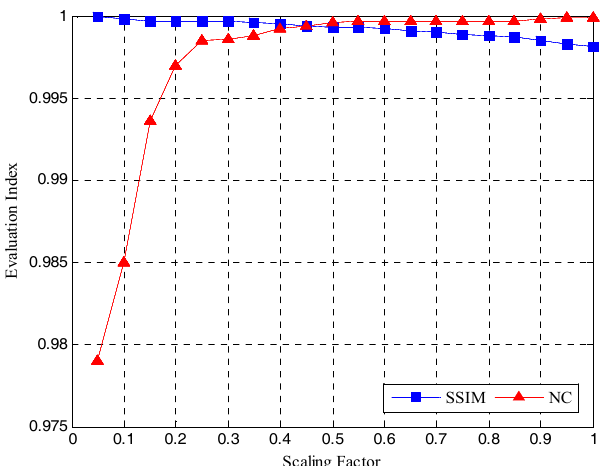
Figure 10. Structural similarity index (SSIM) and normalized correlation (NC) values of the proposed method with different quantization steps.